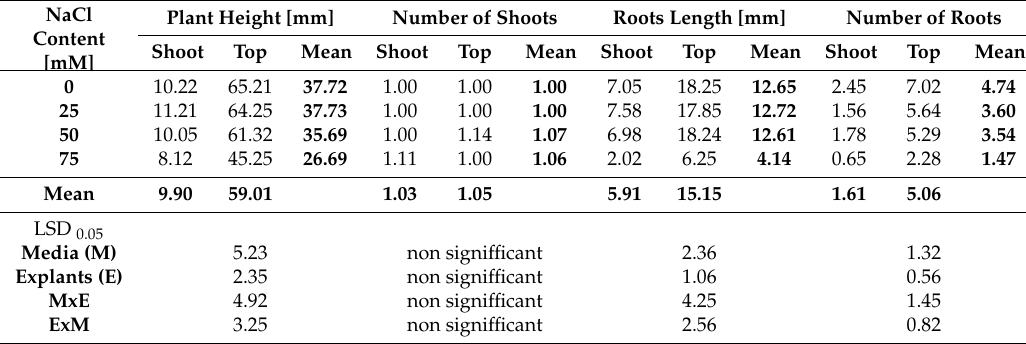
Table 3. Effects of type of explant on the multiplication of Honckenya peploides propagated on MS media with the addition of 1.5 mg ∙ dm − 3 NAA and varied NaCl content.